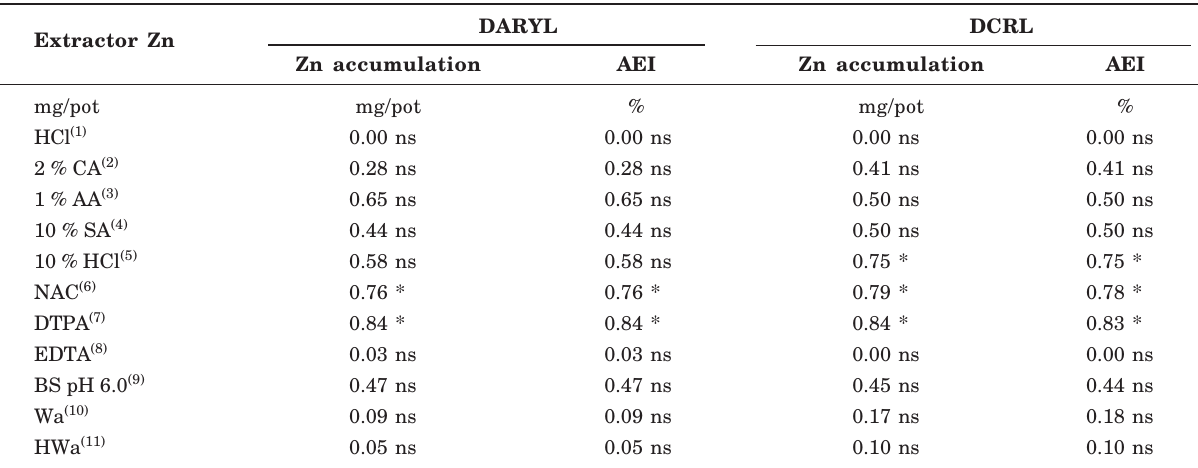
(1) HCl: total Zn content, the official MAPA method. (2) 2 % CA: 2 % citric acid. (3) 1 % AA: 1 % (v/v) acetic acid. (4) 10 % SA: 10 % (v/v) sulfuric acid. (5) 10 % HCl (v/v). (6) NAC: neutral ammonium citrate + water in the ratio 1:1. (7) 50 mmol L -1 DTPA. (8) 5 mmol L -1 EDTA. (9) BS pH 6.0: buffer solution pH 6.0. (10) Wa: water. (11) HWa: hot water. DARYL: Dystrophic Alic Red Yellow Latosol with medium texture. DCRL: Dystrophic Clayey Red Latosol. AEI: agronomic efficiency index of sources calculated based on Zn accumulation in the shoots. ns and *, not significant and significant at 5 %,